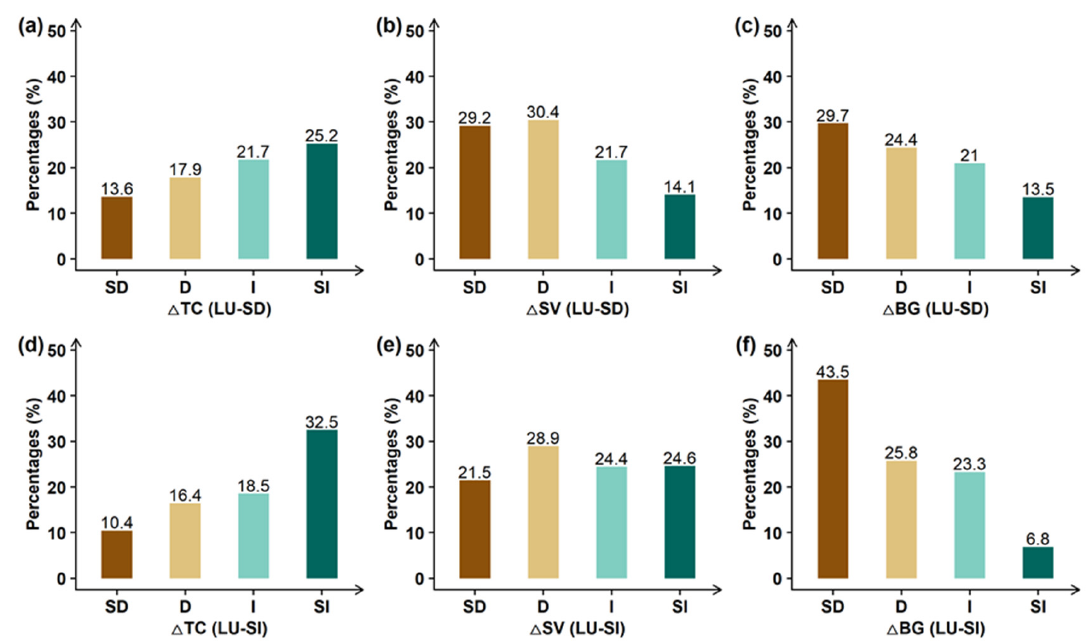
Figure 10. The roles of special land cover types in the effects of land use (LU) on vegetation change. The percentage of areas with significant decrease (SD), decrease (D), increase (I), and significant increase (SI) in different land cover types for the regions showing significant ( a – c ) negative and ( d – f ) positive impacts of land use on vegetation change. TC, SV, and BG represent the areas covered by tree canopy, short vegetation, and bare ground, respectively.